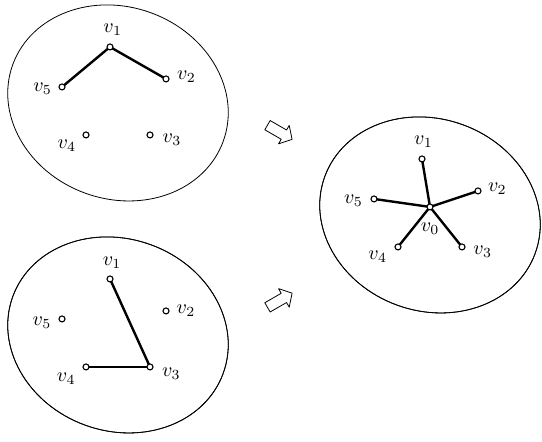
Figure 3: An example of double